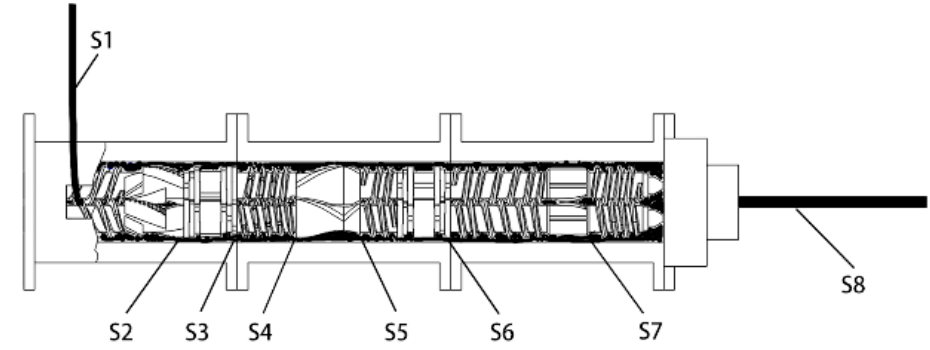
Figure 5. Schematic diagram of sample position.